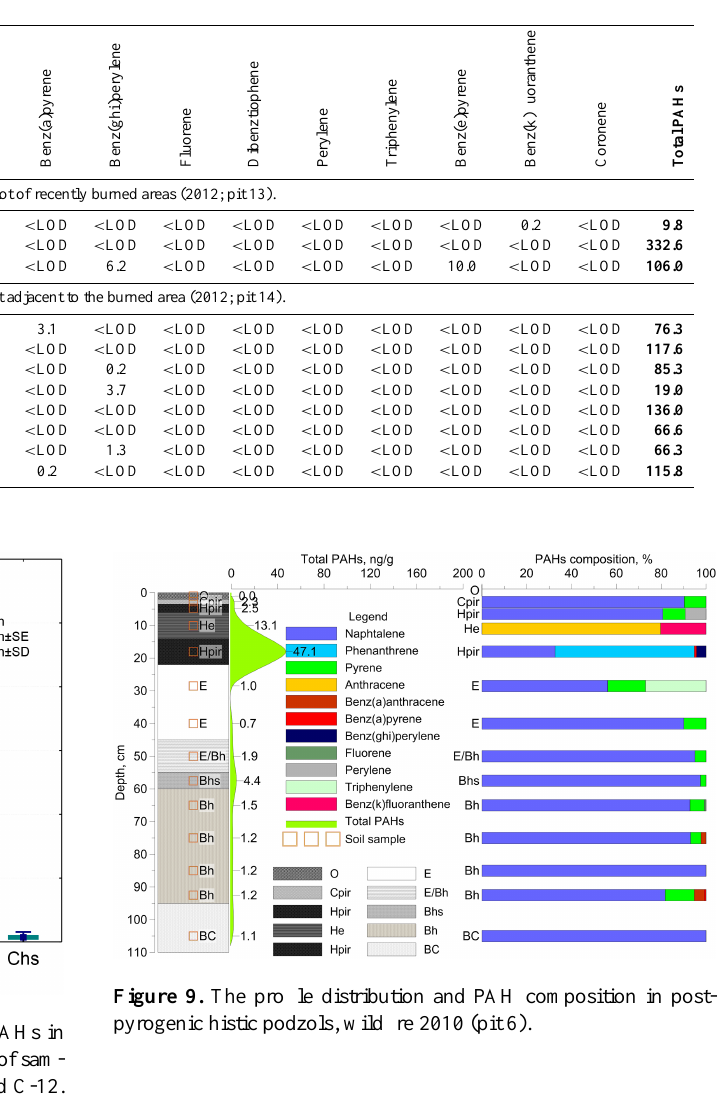
Table 4. PAH concentrations (ngg − 1 ) in soils of recently burned areas (2012).